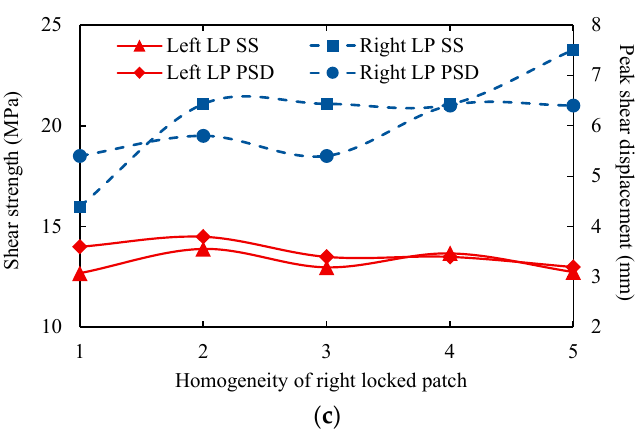
Figure 9. Relationships between ( a ) the depth of right locked patch, ( b ) the height of right locked patch, ( c ) the homogeneity of right locked patch vs. shear strength and peak displacement of two locked patches. LP denotes locked patch, and SS and PSD represent shear strength and peak shear displacement, respectively.